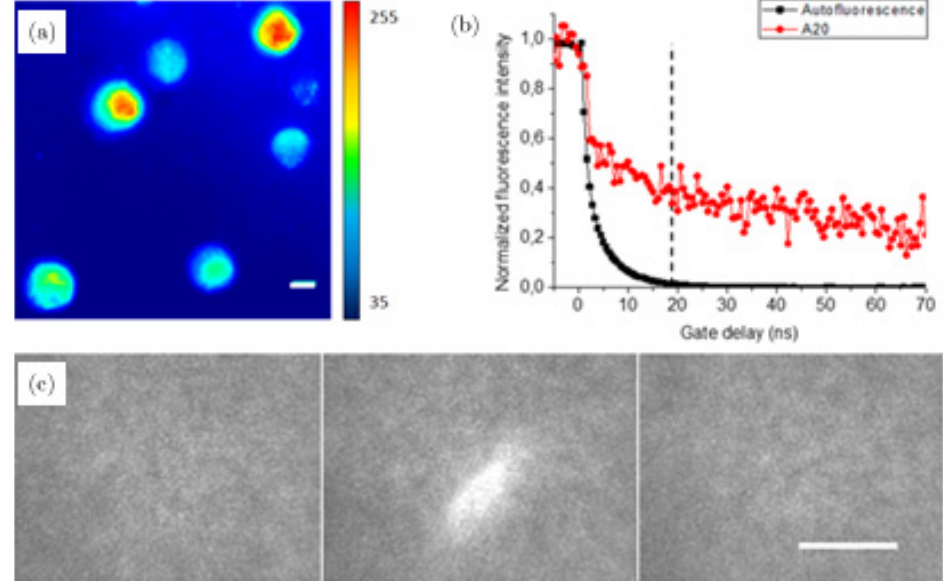
Fig. 9. TG imaging of QD-labeled A20 tumor cells in a rat bloodstream. (a) Classical epi-°uorescence microscopy image (CW imaging) of the cells. Scale bar: 5 (cid:3) m. (b) The AF (black) and °uorescence of the QD-loaded A20 cells (red) as a function of TG delay. (c) Three consecutive in vivo TG °uorescence images showing a QD-labeled A20 cell °owing in a blood vessel. Scale bar: 50 (cid:3) m. Reprinted with permission from Ref.